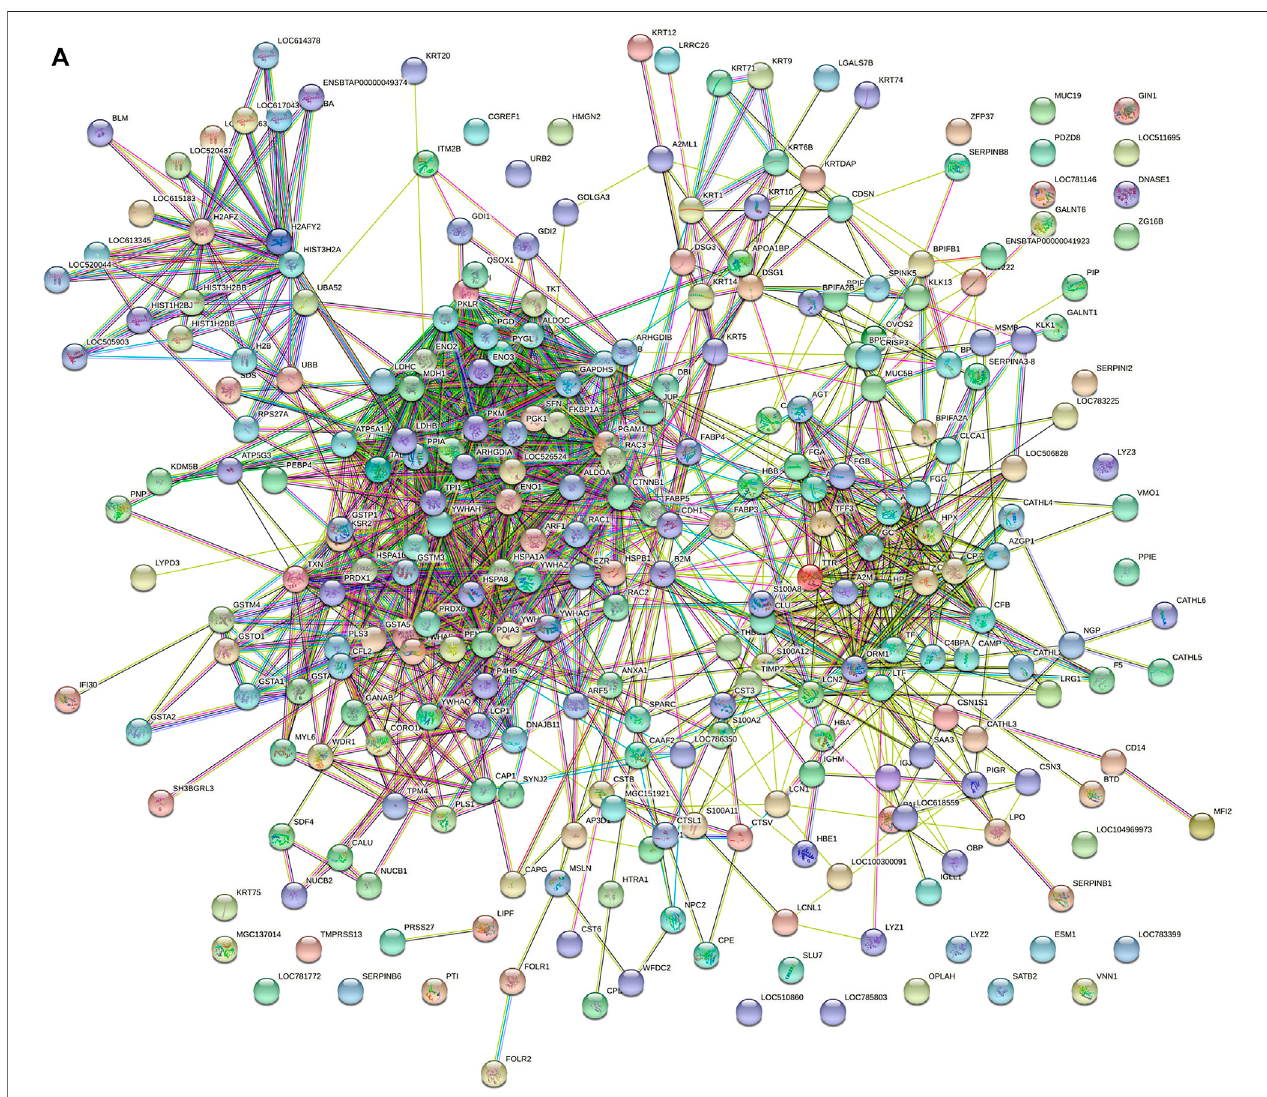
FIGURE 13 | (A) Protein – protein interaction (PPI) network constructed by the STRING tool using combined score of 0.9 – 0.4. A PPI network with high combined score was created ( p < 1.0E-16) with 378 nodes, 810 edges, 4.29 average node degree, and 0.357 average local clustering coef fi cient. (B) Functional annotation of a protein – protein interacting hub using Cytoscape software with ClueGO